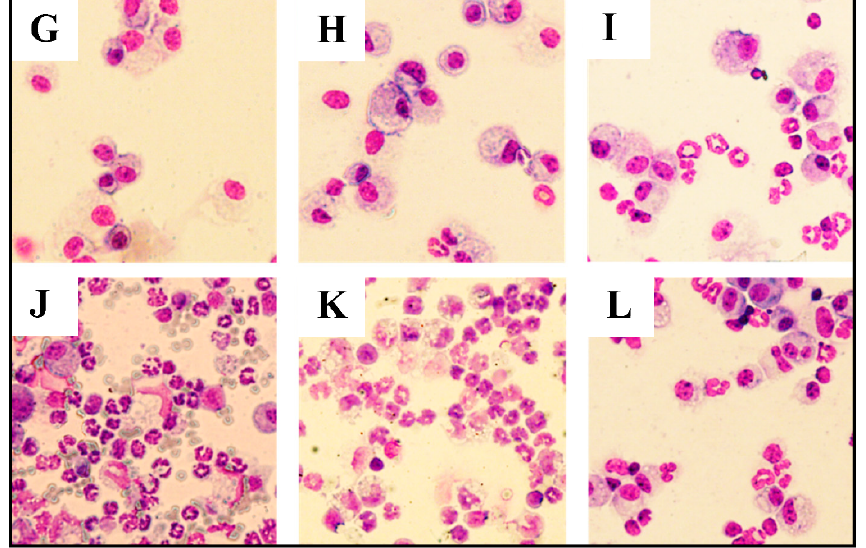
Figure 2. Maraviroc reduces neutrophil and macrophage infiltration in the airways of CSH1N1 mice. Effect of dexamethasone (DEX) or Maraviroc (MVC) on the BALF accumulation of neutrophils ( A , B ), macrophages ( C , D ), and lymphocytes ( E , F ) of mice exposed to Cs and infected with influenza A virus (CsH1N1). Data are expressed as mean ± SEM from at least 6 mice per group. * for p < 0.05. Differences were statistically evaluated One-Way ANOVA with Tukey post-test. Representative images (400× magnification) of cells recovered from BALF and stained with May-Grünwald Giemsa for Air ( G ), Cs ( H ), H1N1 ( I ), CsH1N1 ( J ), CsH1N1 + DEX ( K ), CsH1N1 + MVC ( L ) groups.